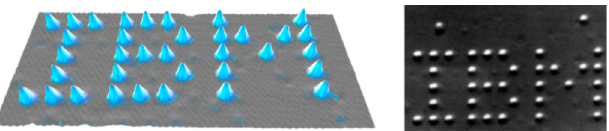
Figure 7. 35 Xenon atoms positioned on a nickel (110) substrate using a STM to form IBM logo. Reproduced with permission from reference [23].